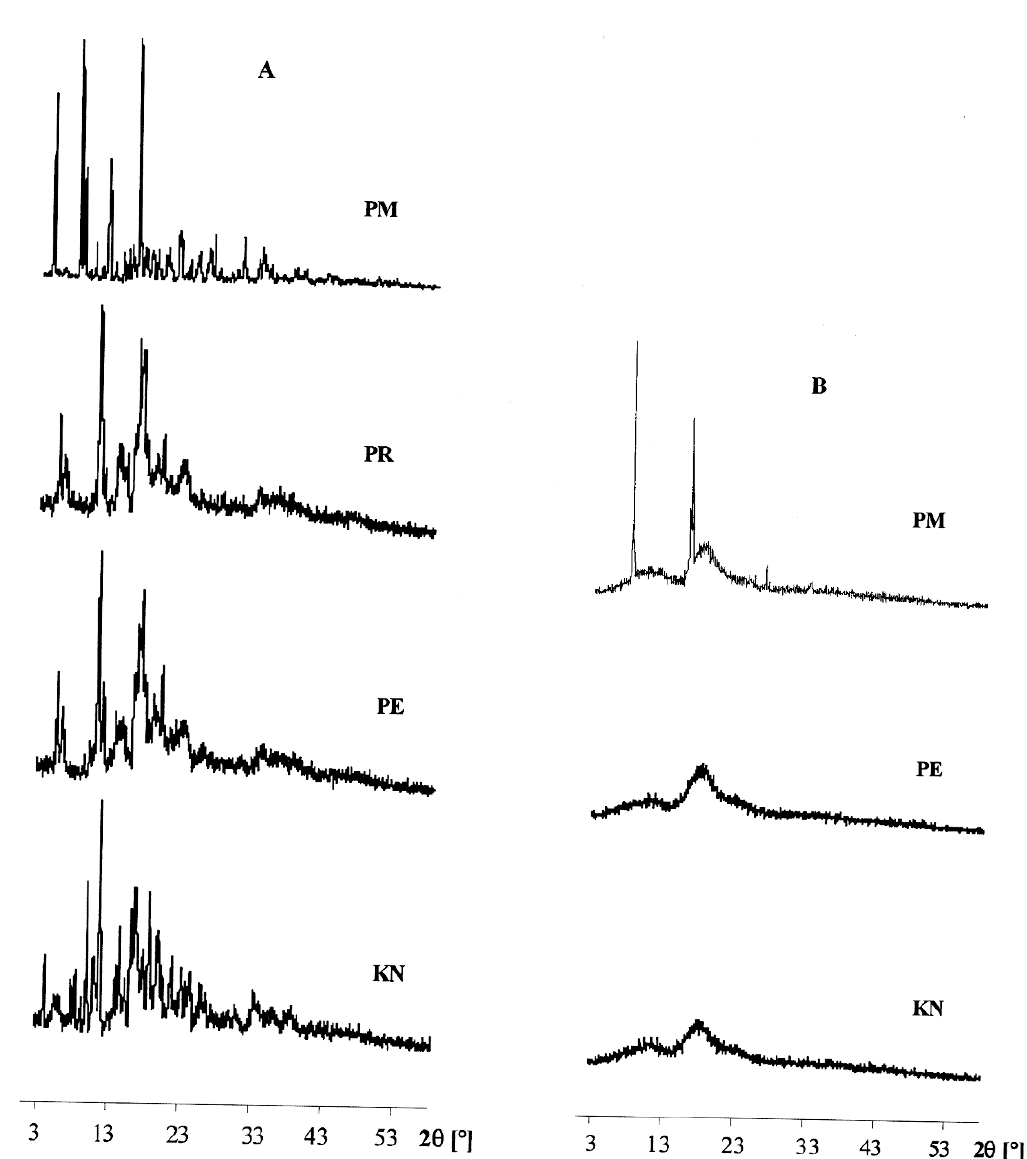
Figure 8. X-ray diffraction patterns of physical mixtures of salicylamide (PM) and its inclusion complexes (PR, PE, KN) with β -cyclodextrin (A) and 2-hydroxypropyl- β -cyclodextrin